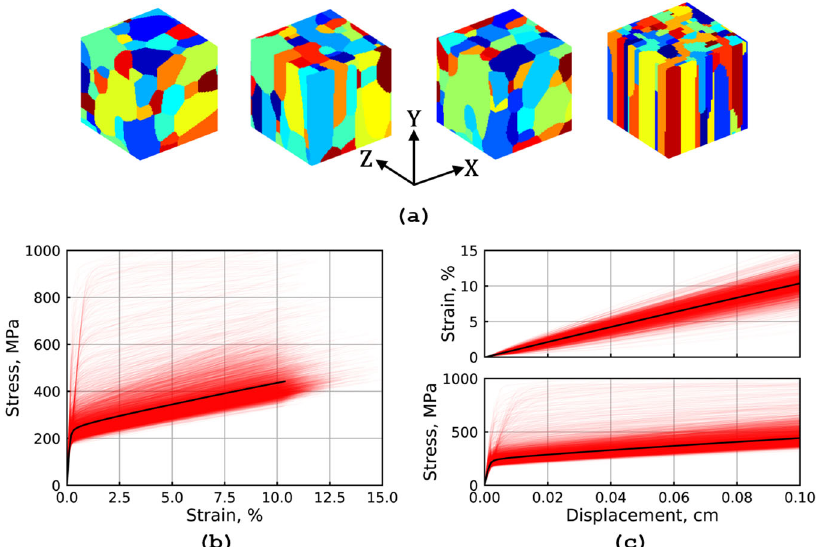
Fig. 3 fGP training data. a Selection of four RVEs from the 50 generated and used for training. b Stress – strain curves of each grain (red lines) in the training data set along with the mean response of all the training data (black line). c Training stress and strain data shown against the commanded